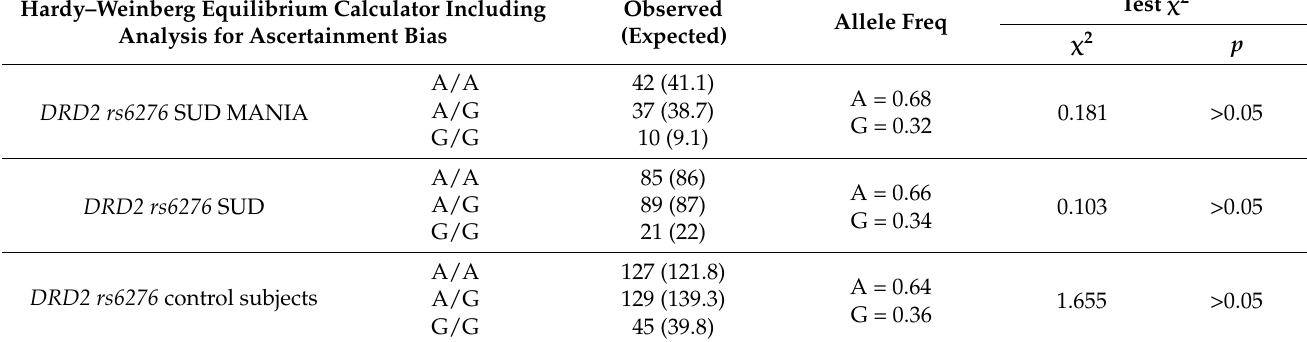
Table 2. Hardy–Weinberg’s analysis for patients diagnosed with polysubstance use disorder comorbid with a maniacal syndrome (SUD MANIA) for patients diagnosed with substance use disorder without mania (SUD) and healthy control